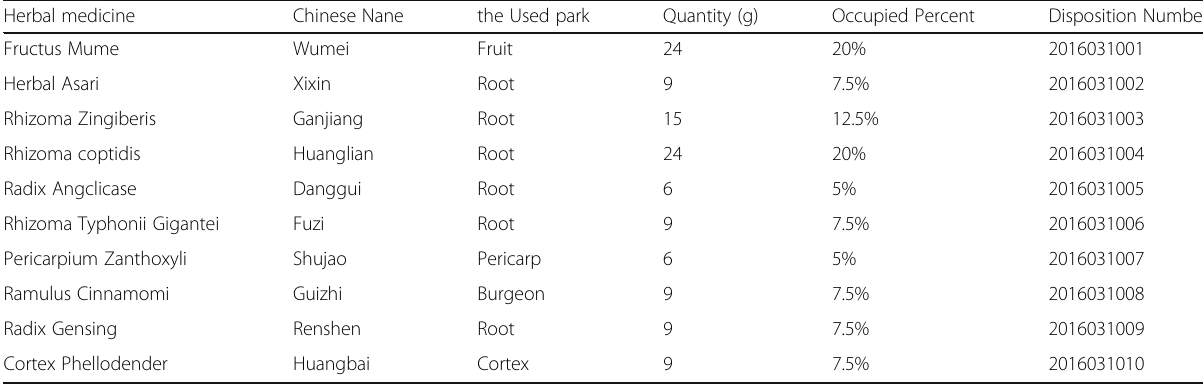
Table 1 The Composition of Wu-Mei-Wan(WMW) Herbal medicine